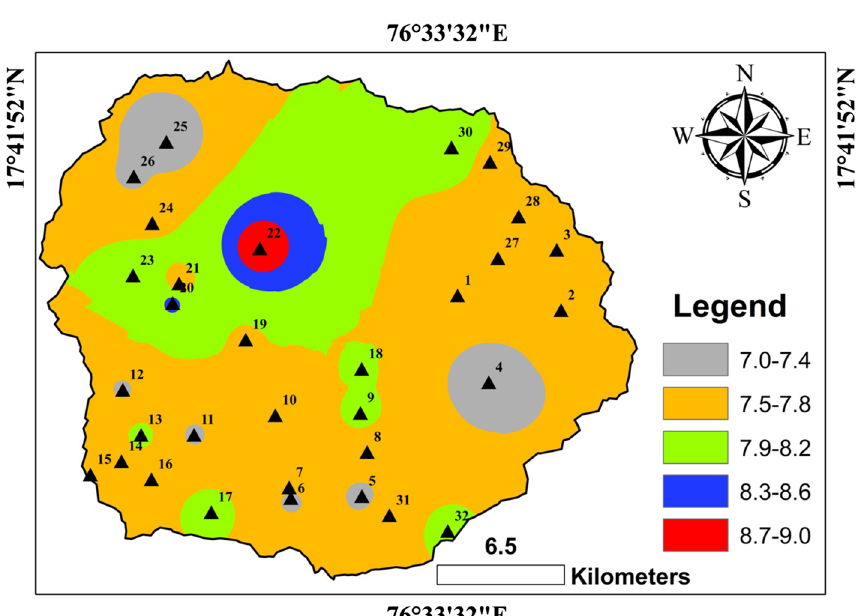
Fig. 3 Geospatial distribution of pH